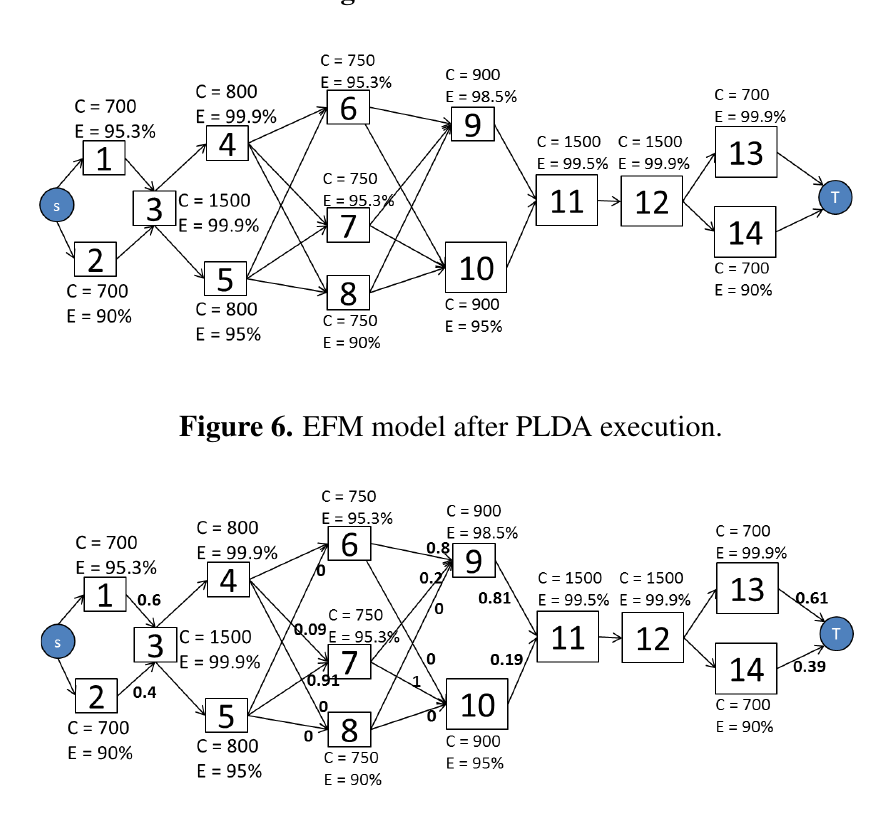
Figure 5. EFM model.